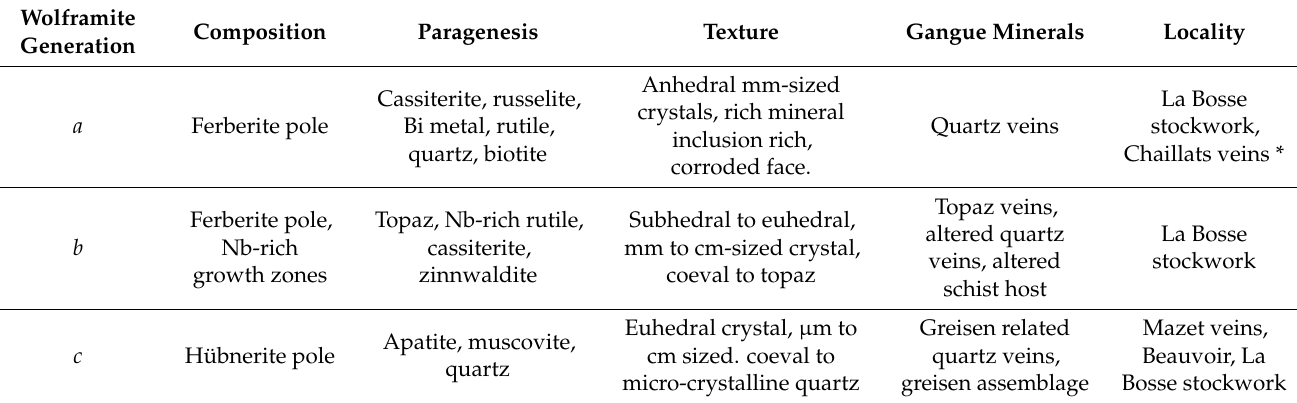
Table 1. Main features of the principal wolframite generations from the Echassi è res district; see [35,44,45] for more details.